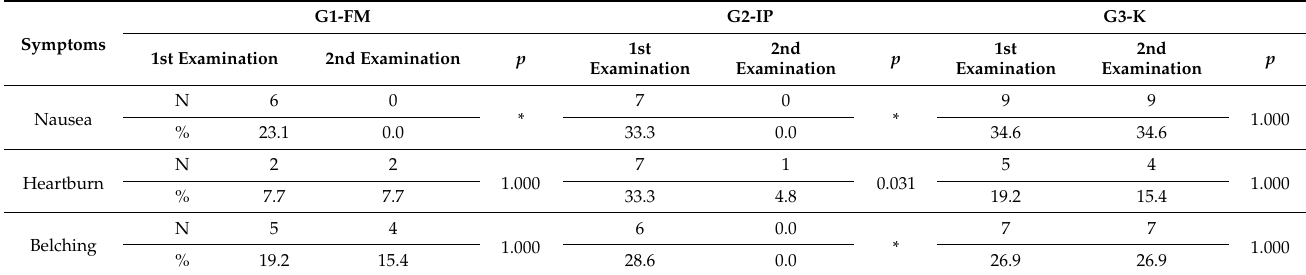
Table 3. Frequency of dyspeptic IBS symptoms in studied patients before and after dietary treatment.